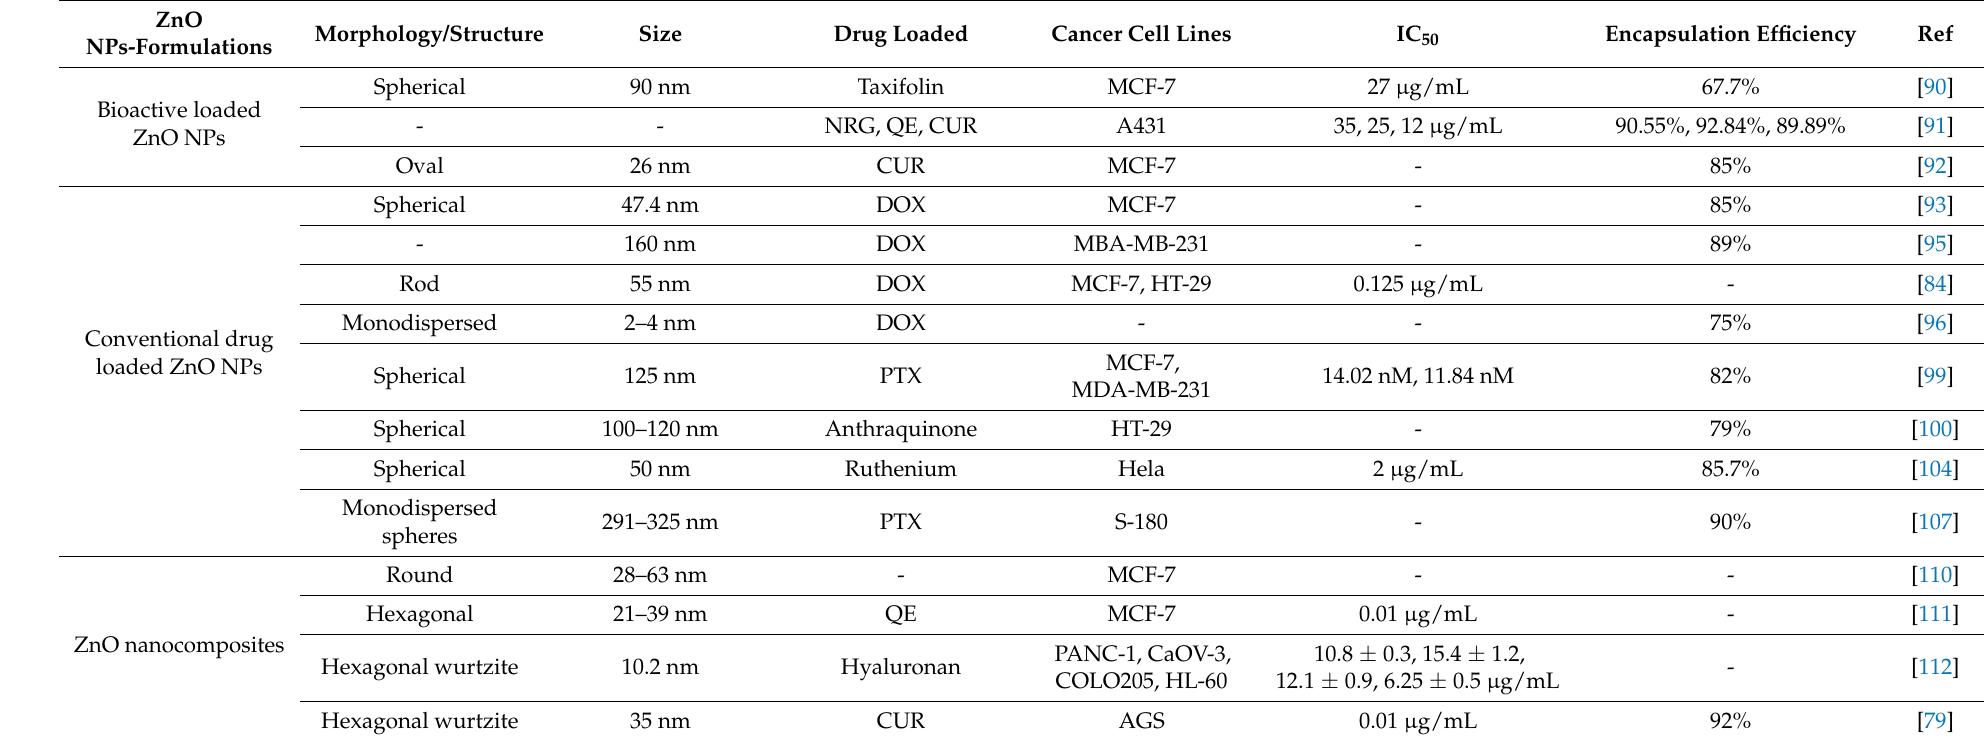
Table 1. Role of various ZnO NPs-formulations in targeted/sustained delivery of anticancerous